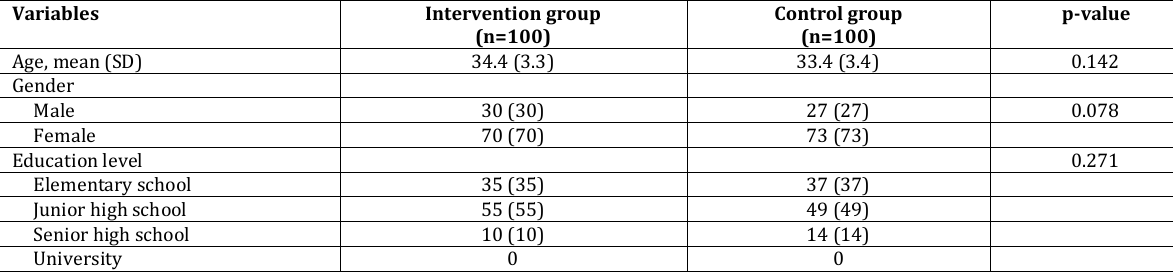
Table 1. Demographic characteristics of respondent (n=200) Variables